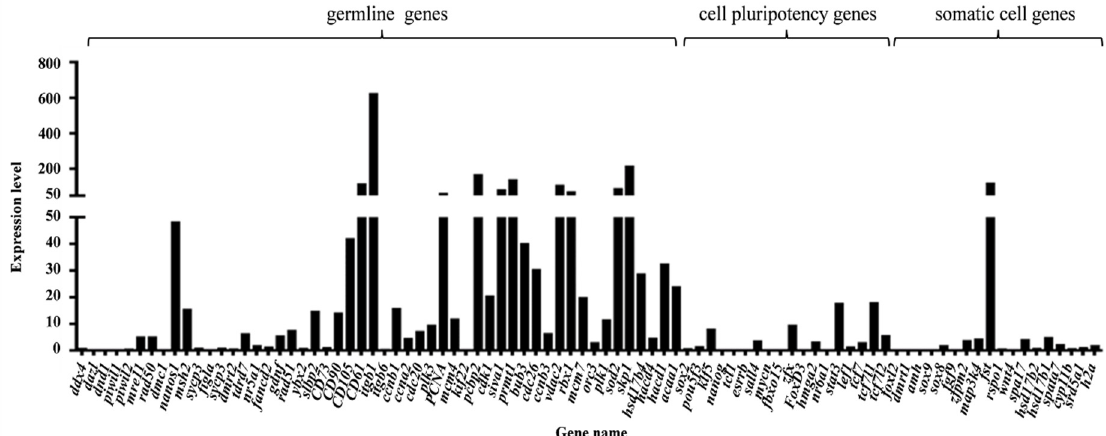
Figure 3. Expression level of related genes in YTO2 cells. These selected genes include well known germline marker genes, cell pluripotency makers and somatic cell genes identified.